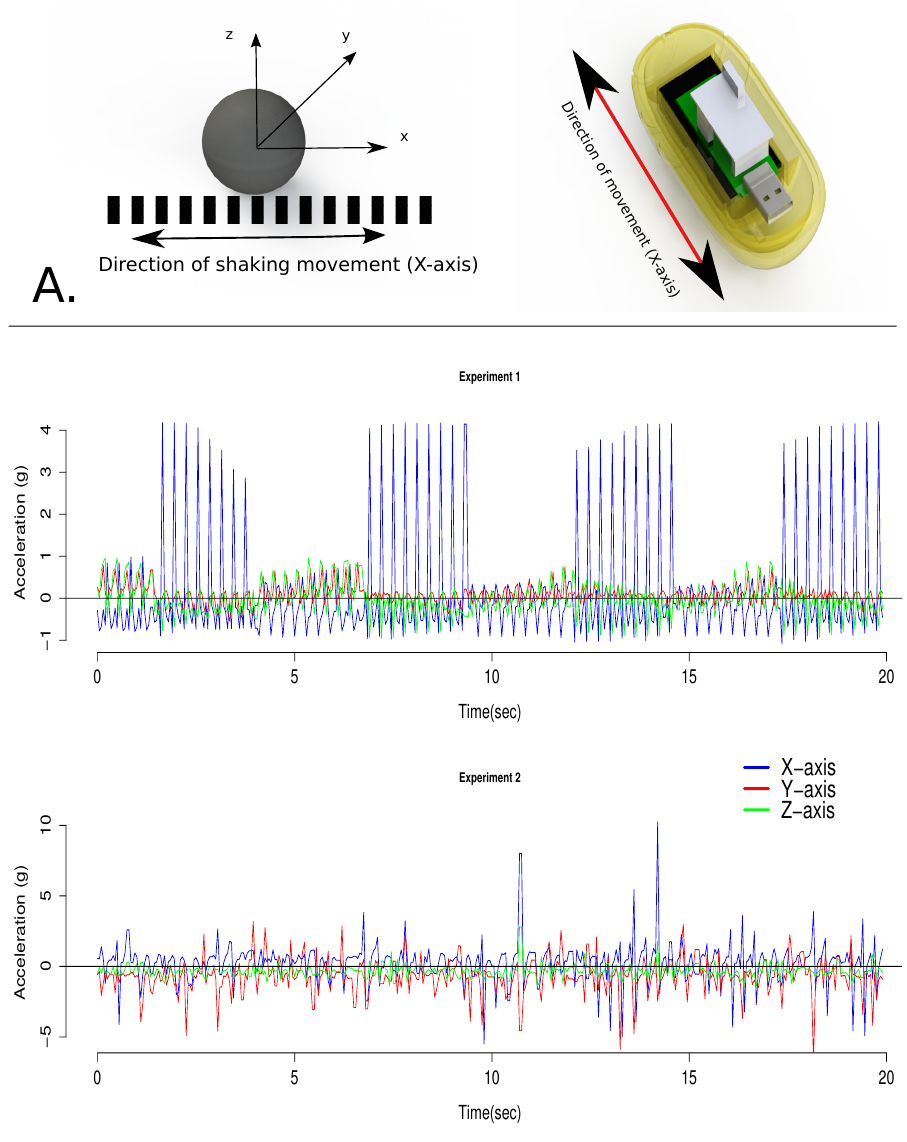
Figure 5. Experimental comparison between steady and unsteady sensor orientations. ( A ) Schematic resolution of the 3D orientation of the sensor in relation to the periodic movement of the shaking table. The table creates a range of accelerations up to 4 g. Left: the axes of acceleration in relation to the outer casing. Right: axis of shaking (x-axis) relative to the internal case; ( B ) Comparison of the raw three-axis acceleration for the two experiments (sampling rate 20 Hz. During Experiment 1, periodic x-axis accelerations reach a maximum of 4.2 g, which significantly exceeds the maxima on the y- and z-axes (0.85 g and 0.96 g, respectively), confirming the direction and magnitude of the dominant process (periodic movement along the x-axis). Experiment 2 was performed without the internal case; hence, sensor orientation changed through time. The maximum acceleration for the = 10 g). Moreover, the x-axis is much larger than that produced by the shaking table ( x max periodic movement is not recorded, and the comparison with the maxima on the other axes (3.18 g and 2.8 g on the y- and z-axes, respectively) is not indicative of the dominant process.